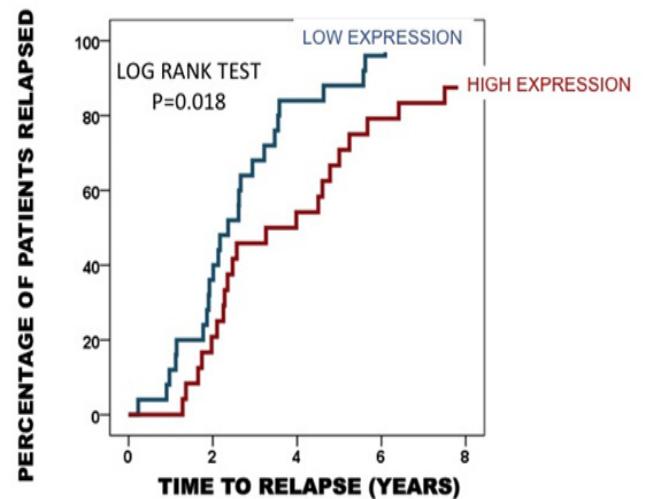
Figure 1. Kaplan Meier plot demonstrates that those patients whose tumours express high pAR 791 in the cytoplasm (24 patients) have a longer time to disease recurrence than those patients whose tumours exhibit low pAR 791 expression (25